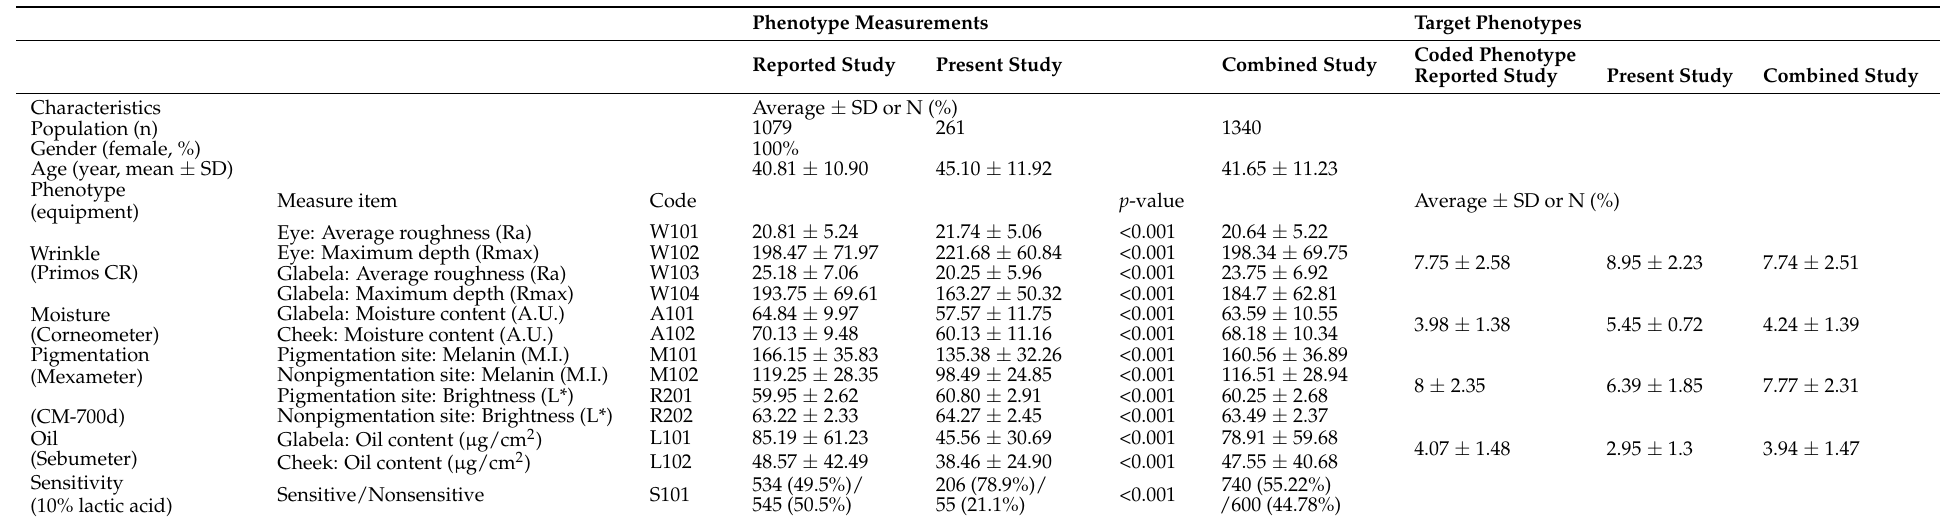
Table 1. Baseline characteristic and skin measurement information of the